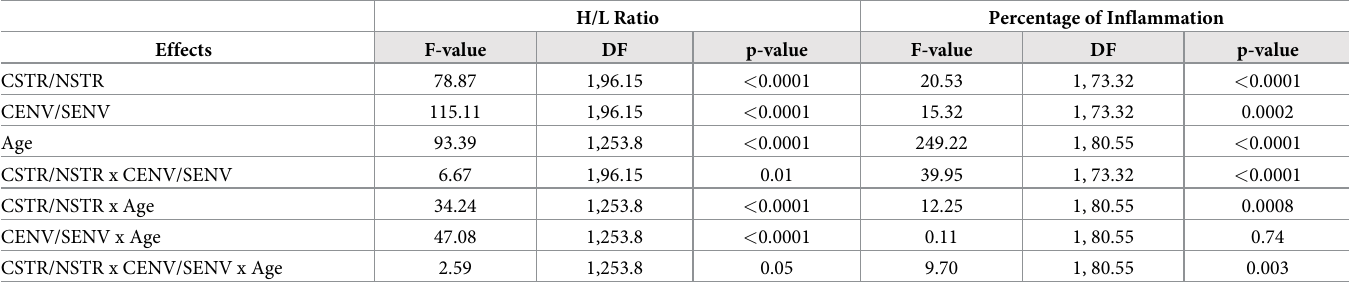
Table 4. Results from the statistical analyses regarding heterophil/lymphocyte (H/L) ratio and the swelling response after the phytohemagglutinin-P (PHA-P) injec- tion, expressed as percentage of inflammation. H/L Ratio Percentage of